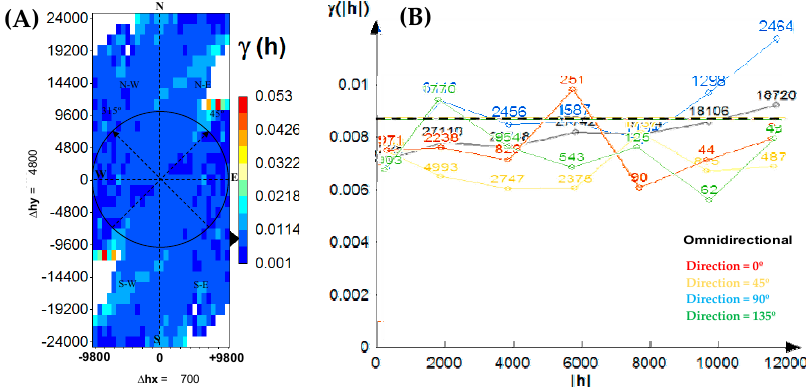
Figure B2. (A) Variographic surface; (B) omnidirectional and directional variogram—Belém urban Figure A2. ( A ) Variographic surface; ( B ) omnidirectional and directional variogram—Bel é m urban zone.